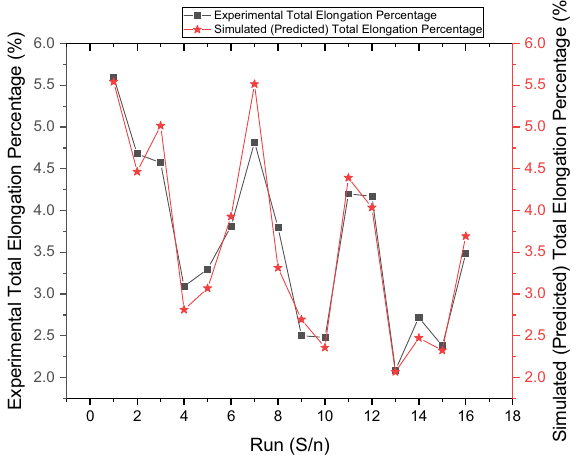
Figure 7. Predicted vs. Experimental plot of percentage elongation of the Al-PP-CCP hybrid